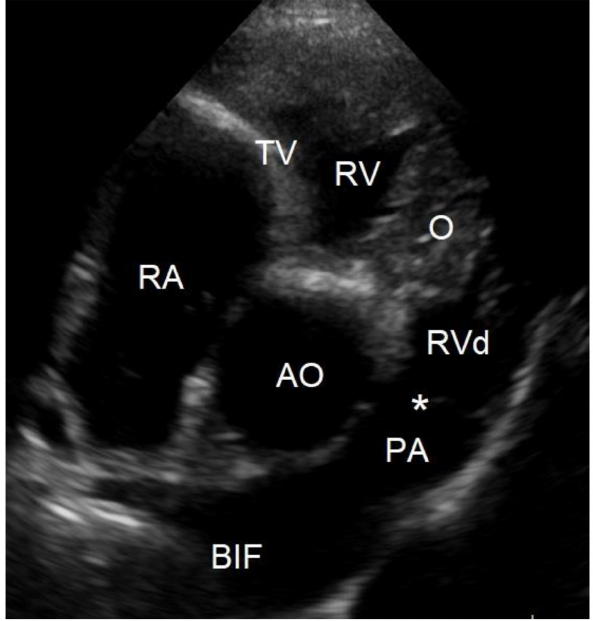
Figure 3. Two-dimensional cross-sectional echocardiographic image at the level of the heart base from the standard right parasternal short axis view at 3 years of age shows a localized muscular hypertrophy in the right ventricle (O). This obstructive muscular lesion resulted in a severe concentric hypertrophy of the right ventricular chamber proximal to the obstruction (RV) as evidenced by a thick wall, compared to the right ventricular chamber distal to the obstruction (RVd), which has a normal wall thickness. AO—aorta, PA—pulmonary artery trunk, *—pulmonic valve, RA—right atrium, TV—tricuspid valve, BIF—pulmonary artery bifurcation.